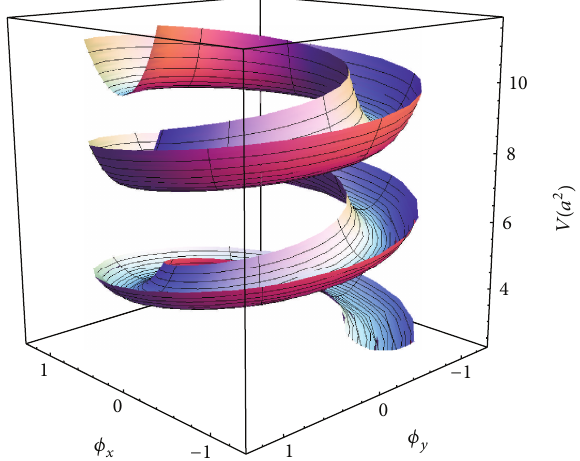
Figure 2: The helicoid structure of potential (31) scaled by 𝑎 2 . The parameters with 𝑐 = 0.96 and 𝑏 = 0.1 are adopted in the graph. It is shown that the local valley locates around 𝑟 ≈ 1 . Note that the potential gets flatter at the top of the